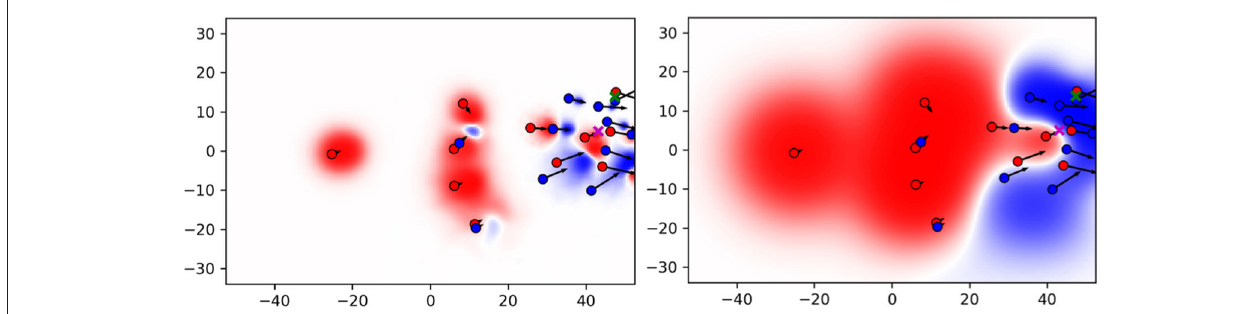
FIGURE 5 | Pitch control (PC) for the proposed approach (Left) and baseline (Right) .